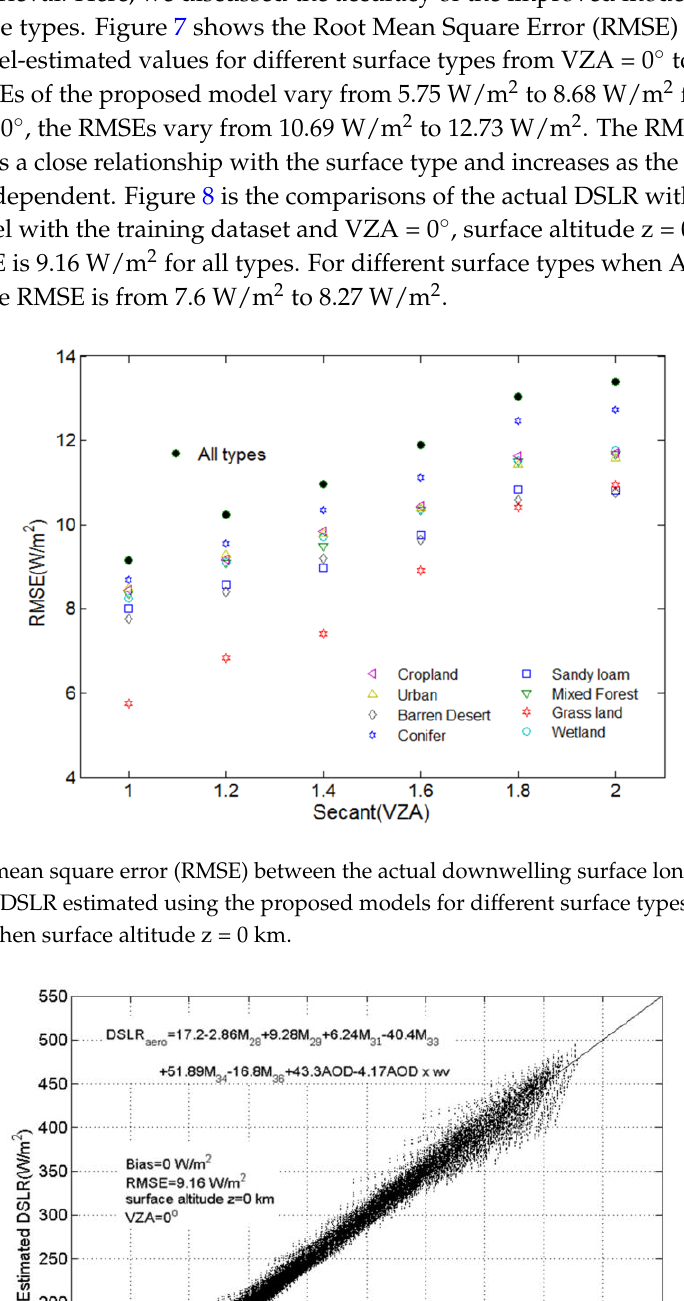
Figure 6. Scattering diagrams of the slope k in Equation (5) as a function of atmospheric WVC under dust aerosol type.